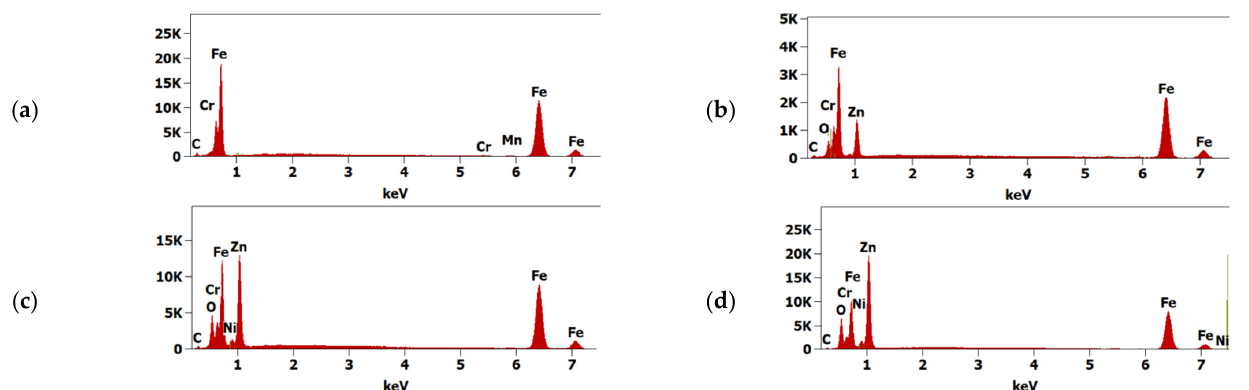
Figure 7. EDS spectrum of the pure scalpel ( a ) and scalpel surface with ZnO thin film deposited after ( b ) 500 cycles, ( c ) 1000 cycles, and ( d ) 1500 cycles.